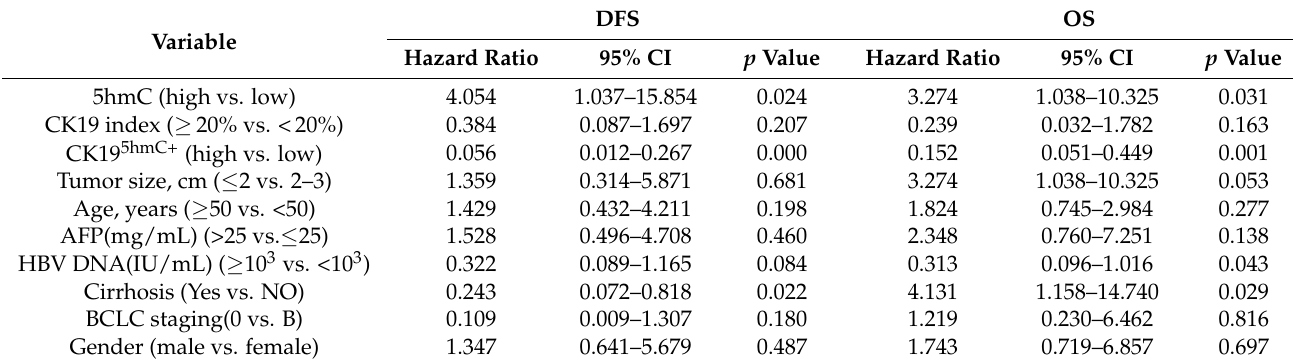
Table 2. Univariate cox analysis on DFS and OS of SHCC.